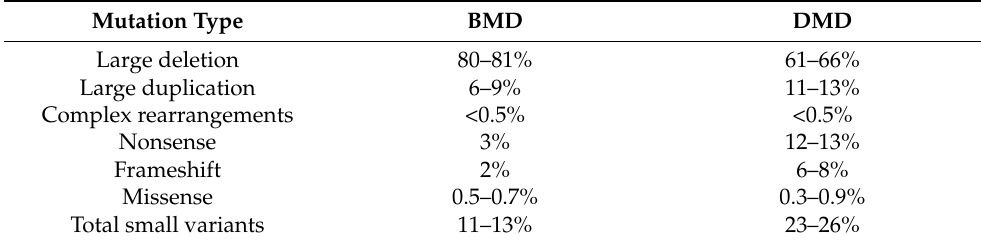
Table 1. Variants of dystrophinopathies